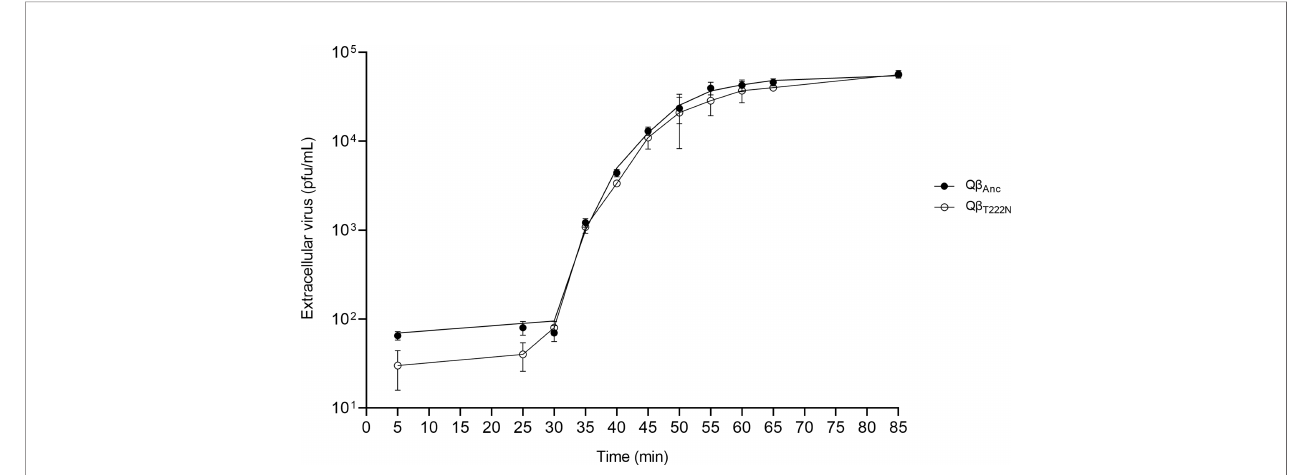
FIGURE 7 | One step growth curve for the viruses Q b Anc and Q b T222N . 10 6 pfu of each virus were pre- incubated for 5 min with ~ 3 x 10 8 cfu in a volume of 1 mL. The fi rst sample (time 5 min in the curves) was taken just after dilution of the cultures (see Materials and Methods). Black circles refer to the virus Q b Anc and white circles to the virus Q b T222N . Each point represents the average of two replicas.